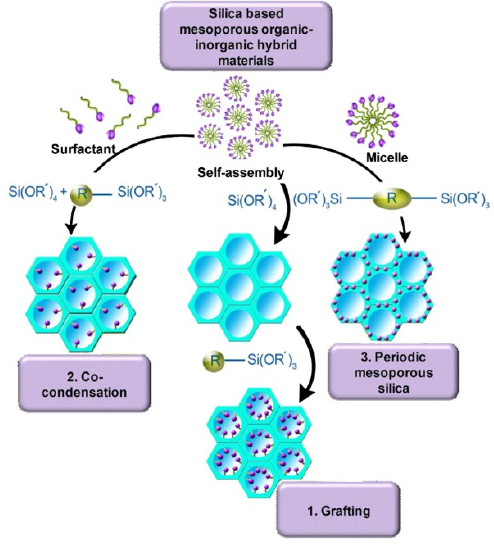
Figure 4. Different methods for the synthesis of organic-inorganic hybrid mesoporous silica: 1. Grafting, 2. Co-condensation or in situ grafting and 3. Periodic mesoporous silica. Reproduced wity permissiom from [93]. Copyright 2006 WILEY-VCH Verlag